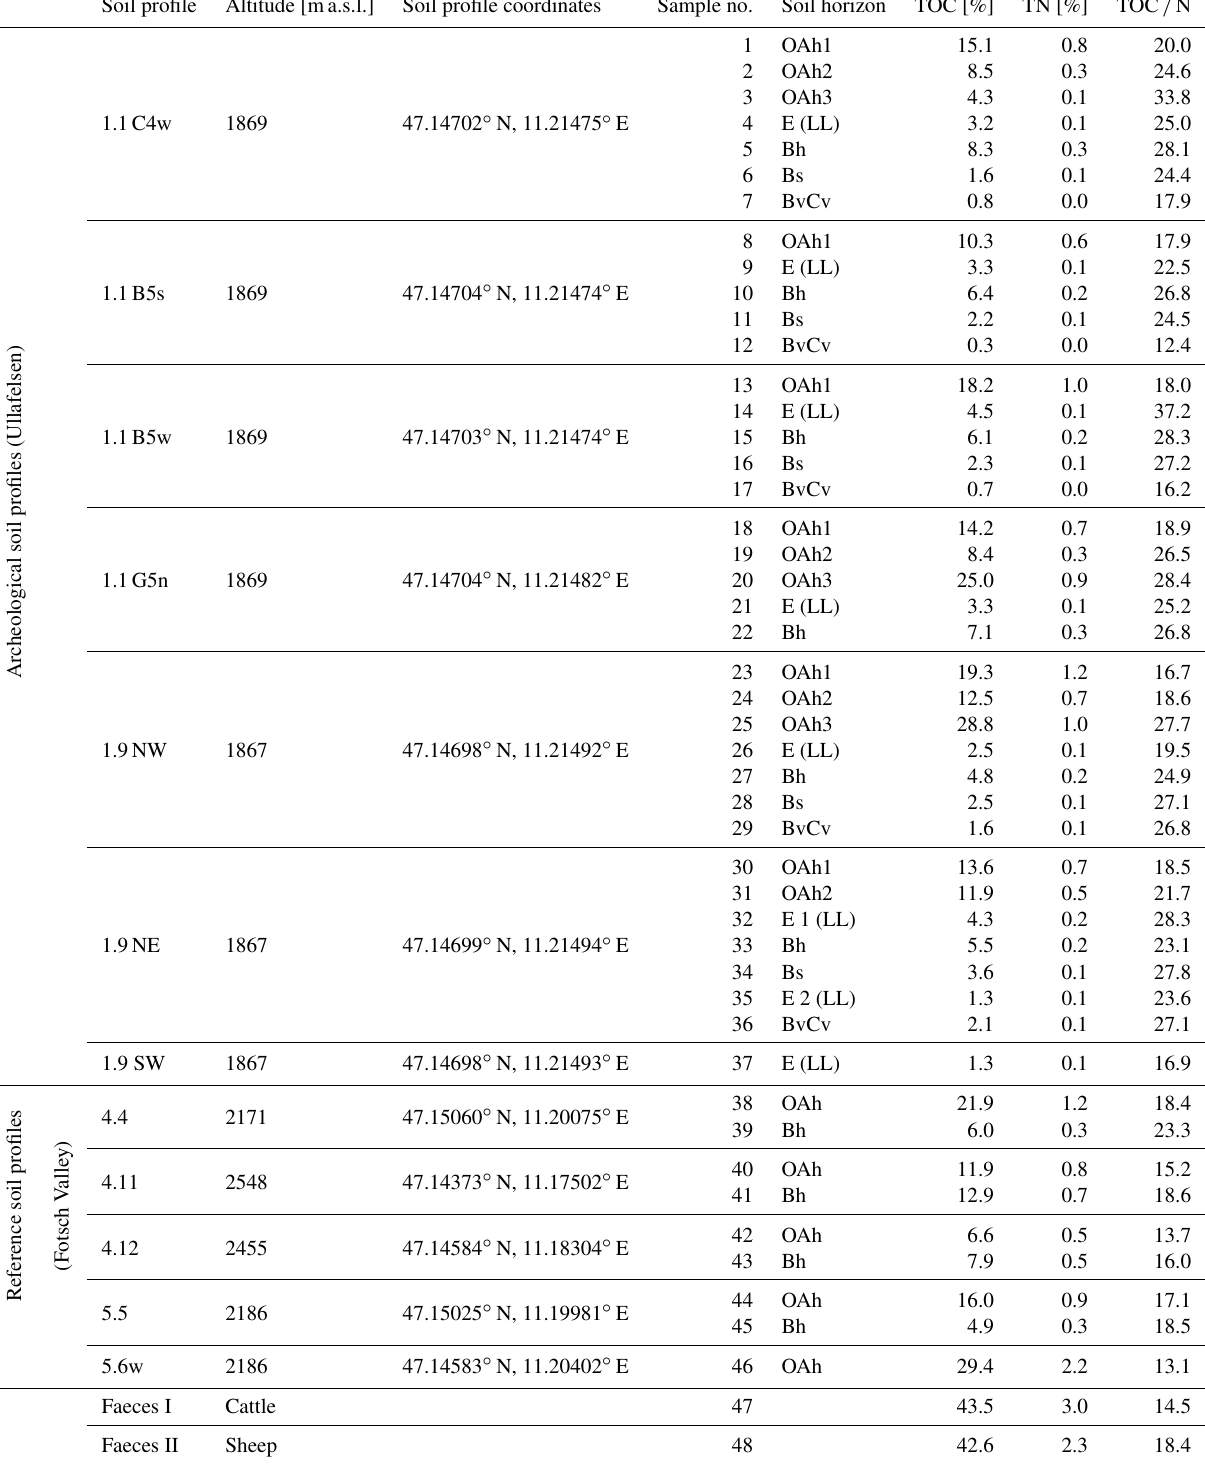
Table 1. Overview of all soil profiles, soil and modern faeces samples from the prehistorical encampment site of Ullafelsen and reference sites in the Fotsch Valley, Stubai Alps, Austria. Analytical results of TOC, TN and TOC / N are presented. Soil profile Altitude [ma.s.l.] Sample